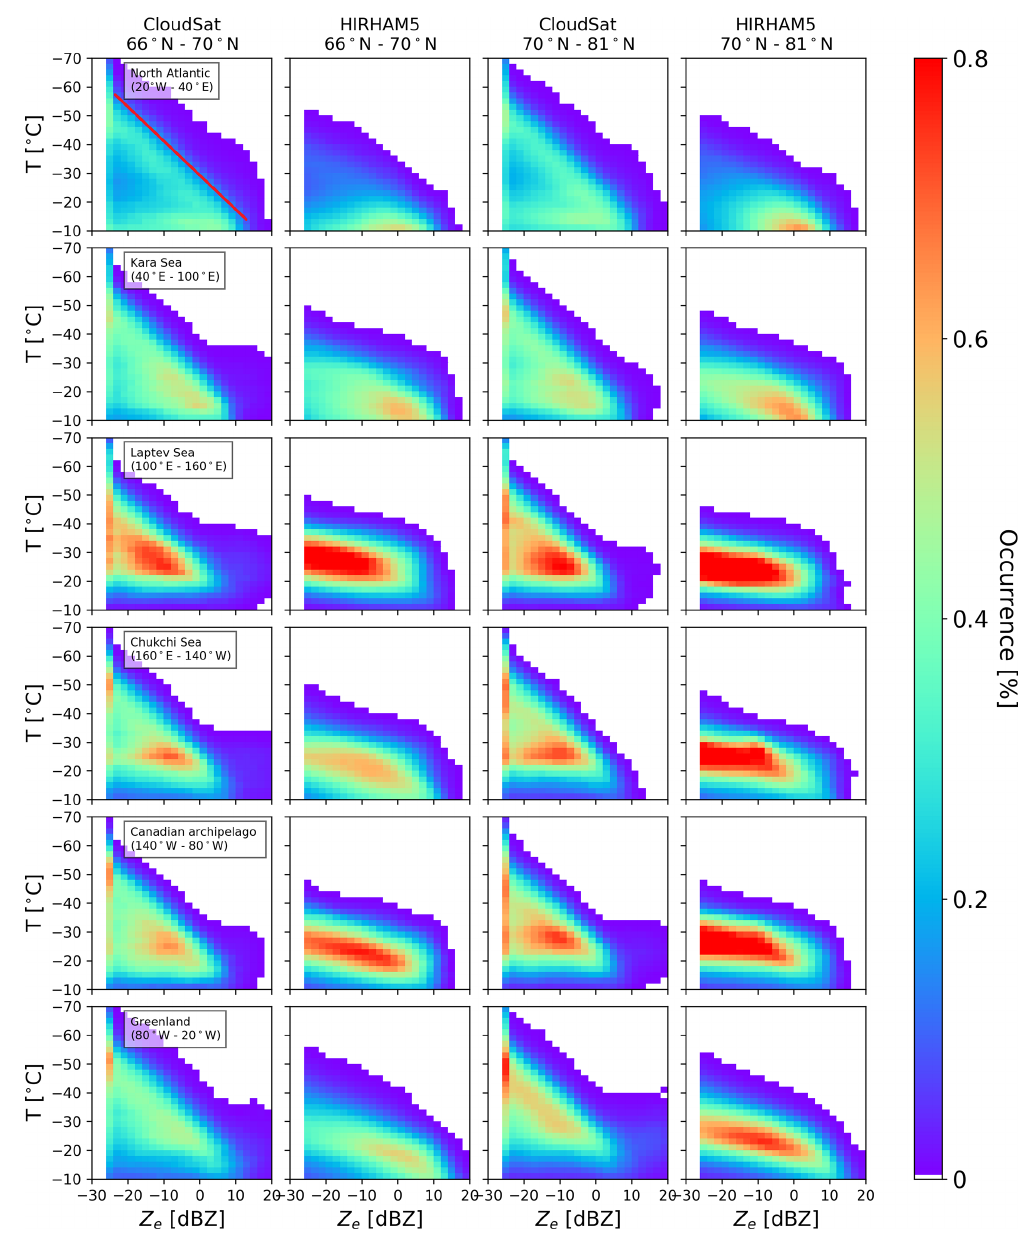
Figure 7. The observed and modeled CFTDs for both latitude band regions in the winter season (DJF, 2007–2010). On the x axis is the reflectivity (dBZ), on the y axis is the temperature from − 70 to − 10 ◦ C, and the normalization is done by the sum of total hits, which varies from region and season, but the total number of hits ranges between 86500 and 6 . 6 × 10 6